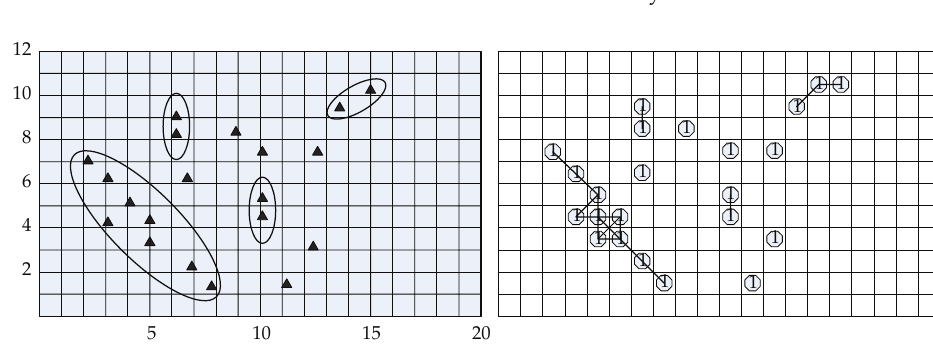
Figure 7: Data example one with graph generated with grid interval 1. Parameters p 0 (cid:8) 1.